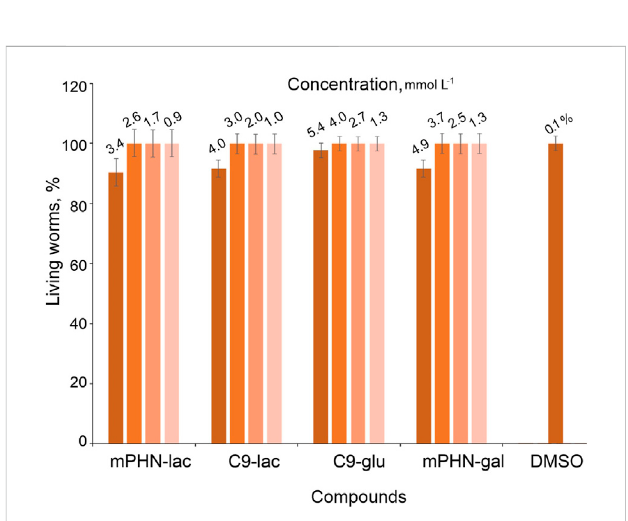
FIGURE 4 Toxicity of the sugar esters against Caenorhabditis elegans after 48 h